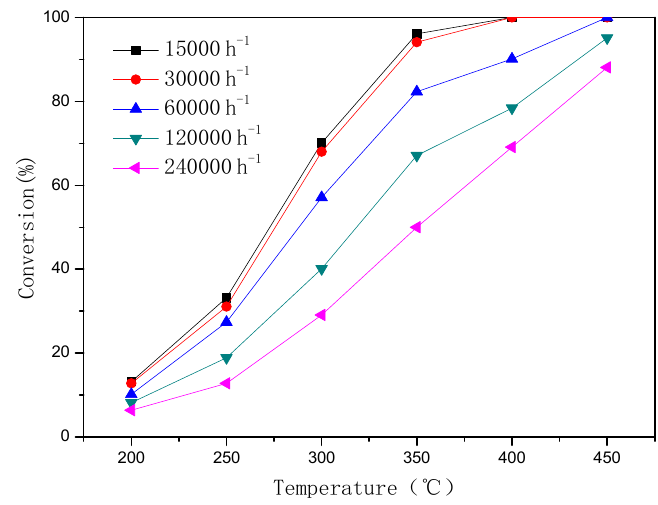
Figure 10. Catalytic oxidation of CB at different GHSVs.